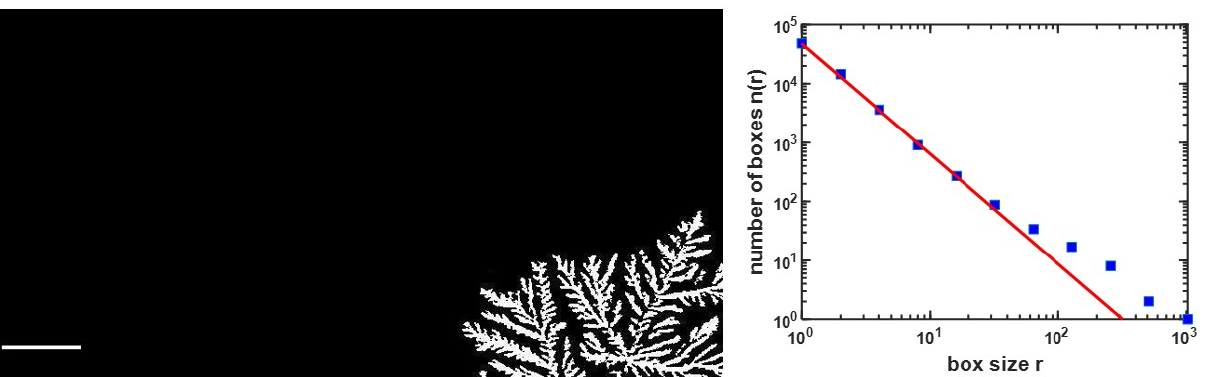
Figure A2. Left: The contrast-enhanced black and white picture of a typical seaweed structure at t = 49.9 s. The scale bar is 100 µ m. Right : The deduced boxplot leading to a fractal dimension of D F = 1.62 ± 0.06 .